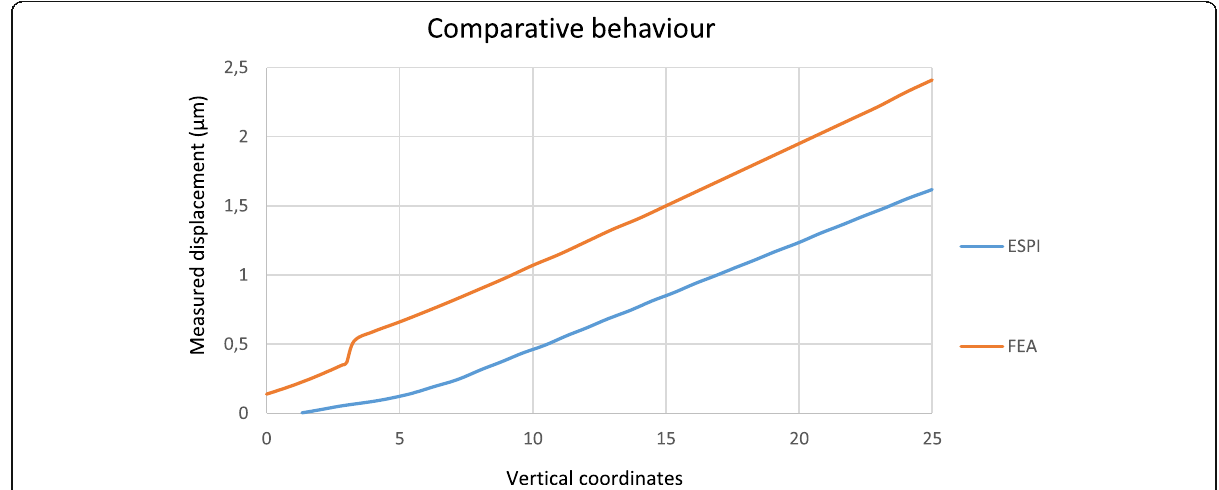
Fig. 6 Comparison between the displacements of the FEA (orange) and the average of the samples used during the ESPI